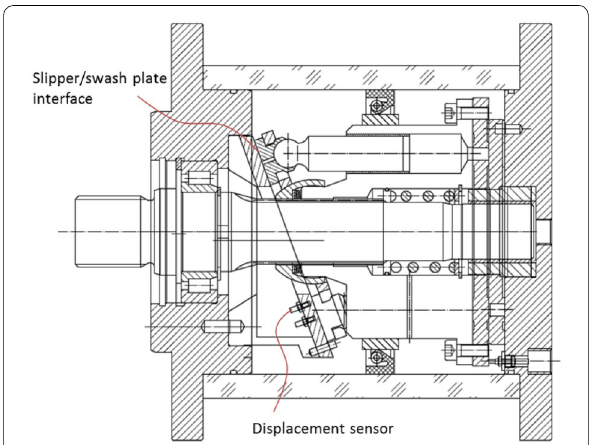
Figure 1 Structure of the test pump